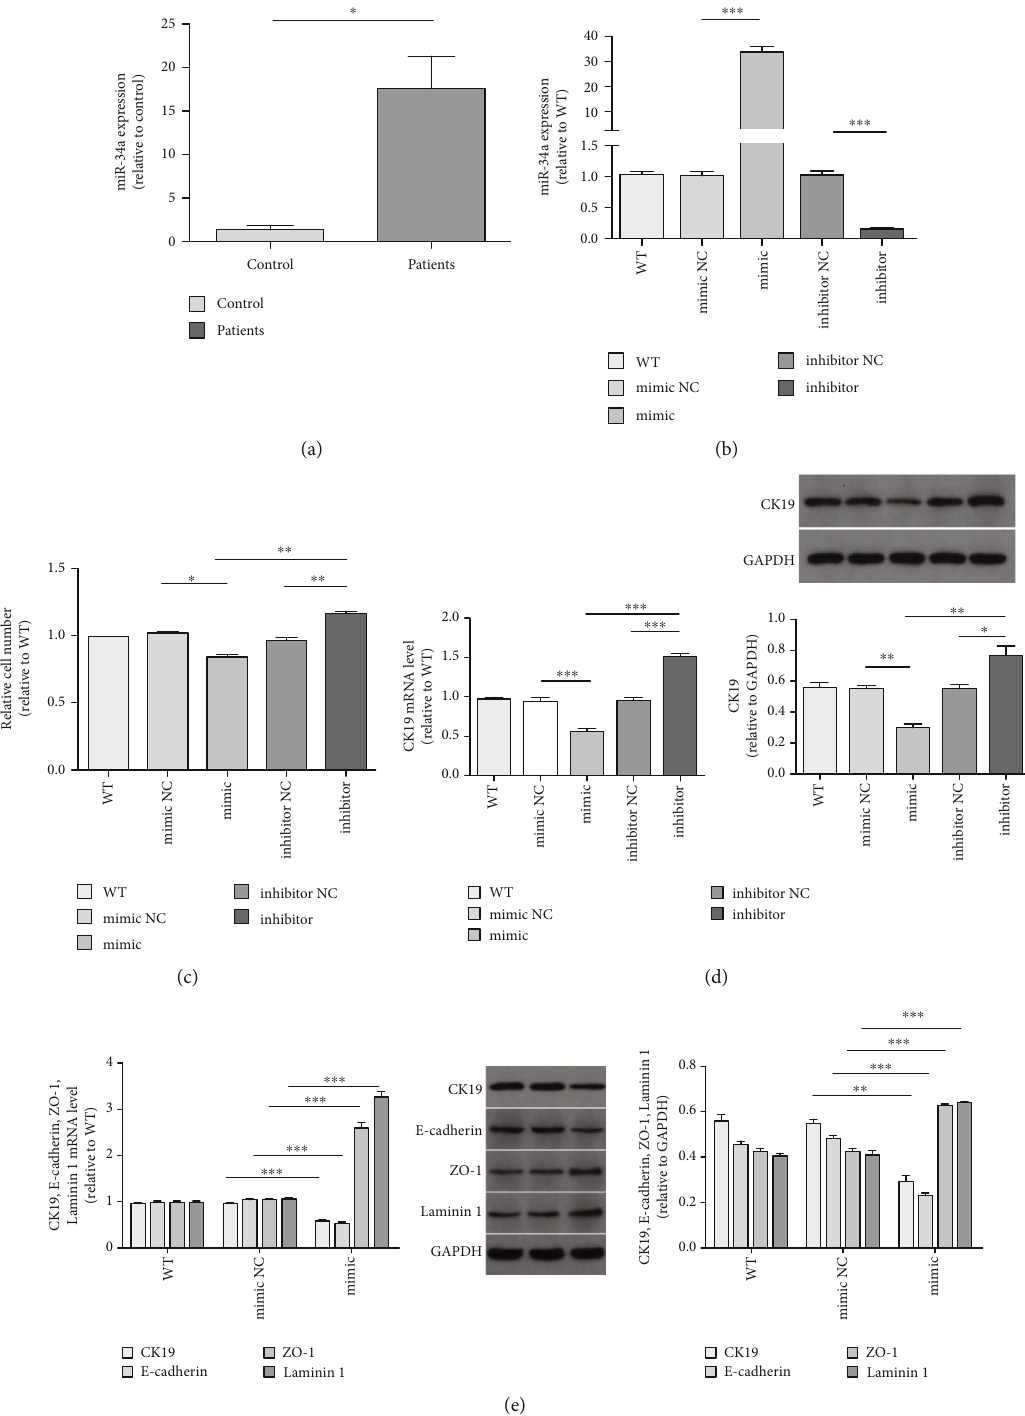
Figure 3: miR-34 expression in the serum of PBC patients and healthy controls and HIBEC proliferation in vitro. (a) miR-34a was signi fi cantly overexpressed in the sera of PBC patients ( P = 0 : 048 ∗ ). (b) Expression of miR-34a of HIBEC transfected by miR-34a mimics, inhibitor, and controls (miR-34a mimics vs. NC, P < 0 : 0001 ∗∗∗ and miR-34a inhibitor vs. NC, P < 0 : 0001 ∗∗∗ ). (c) Relative cell number measured by using CCK8 (miR-34a mimics vs. NC, P = 0 : 0155 ∗ ; miR-34a mimics vs. inhibitor, P = 0 : 0039 ∗∗ ; and miR-34a inhibitor vs. NC, P = 0 : 0037 ∗∗ ). (d) CK19 mRNA level of each group (miR-34a mimics vs. NC, P < 0 : 0001 ∗∗∗ ; miR-34a mimics vs. inhibitor, P < 0 : 0001 ∗∗∗ ; and miR-34a inhibitor vs. NC, P < 0 : 0001 ∗∗∗ ). Relative CK19 protein expression (miR-34a mimics vs. NC, P = 0 : 0013 ∗∗ ; miR- 34a mimics vs. inhibitor, P = 0 : 0026 ∗∗ ; and miR-34a inhibitor vs. NC, P = 0 : 0404 ∗ ). (e) CK19, E-cadherin, ZO-1, and laminin 1 mRNA levels between miR-34a mimics and NC ( P < 0 : 0001 ∗∗∗ , P < 0 : 0001 ∗∗∗ , P < 0 : 0001 ∗∗∗ , and P < 0 : 0001 ∗∗∗ ). CK19, E-cadherin, ZO-1, and laminin 1 protein expressions between miR-34a mimics and NC ( P = 0 : 0013 ∗∗ , P = 0 : 0003 ∗∗∗ , P = 0 : 0007 ∗∗∗ , and P = 0 : 0003 ∗∗